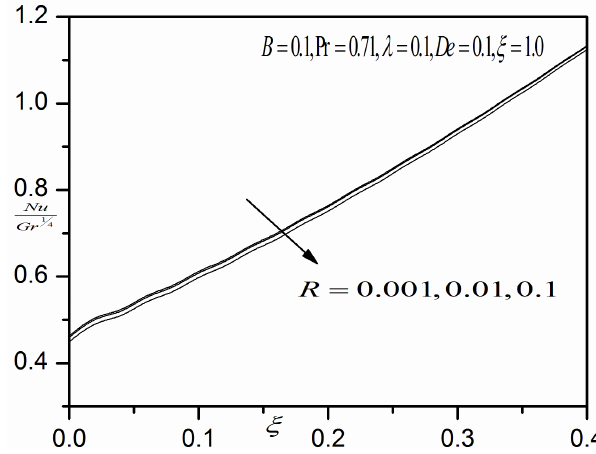
Fig. 18: Influence of R on the Nusselt number.